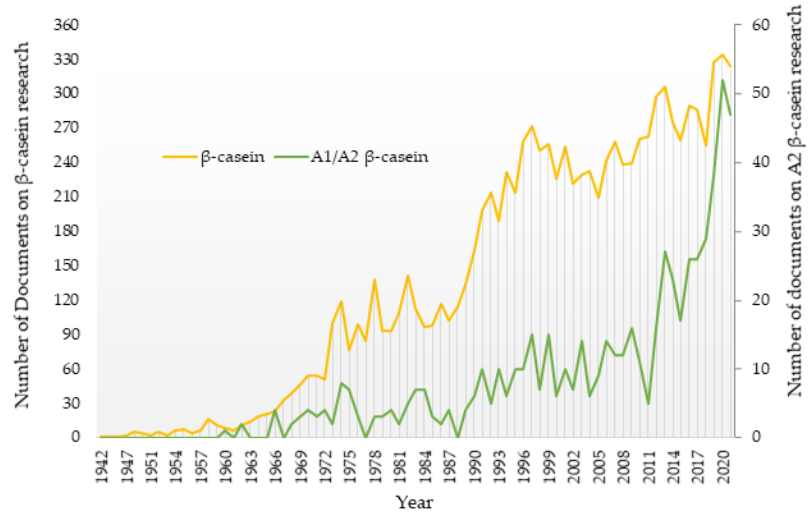
Figure 1. Trends in publications on β -casein research in absolute terms (yellow line) and in the A2/A1 β -casein research field (green line) in the period 1942–2021. Documents from the year 2022 were not included in the figure since the year was not ended at the time of writing.